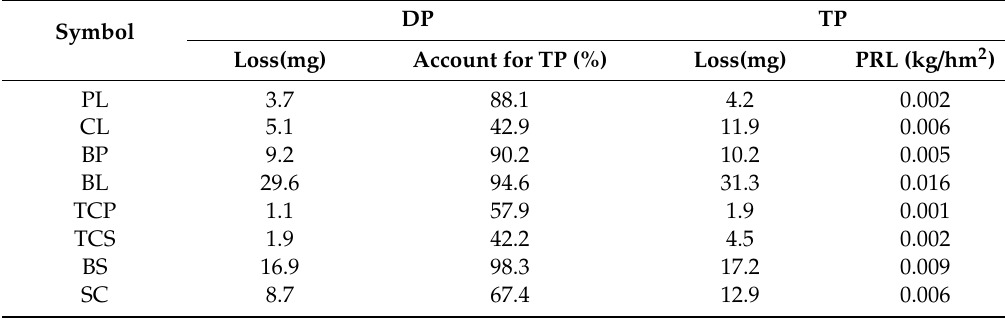
Table 3. Characteristics of phosphorus loss in runo ff under di ff erent crope